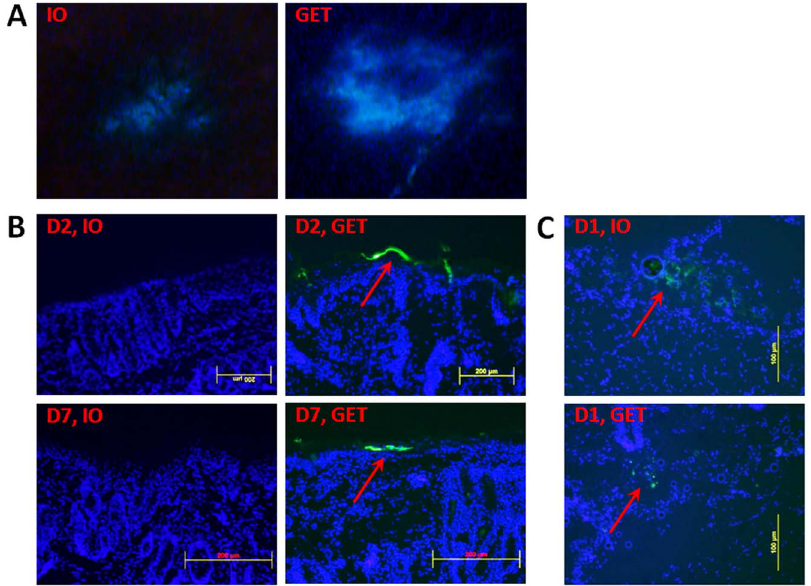
Figure 2. Distribution of GFP-expressing cells in HLGP skin after i.d. DNA injection and non-invasive GET. Skin samples were collected post-delivery day 1, day 2 or day 7. Samples were analyzed by fluorescent stereoscopy or microscopy. IO: DNA injection only without pulse delivery; GET: DNA injection with pulse delivery. A , One representative picture of 3 treated sites. (B, C) Total 6 cryosections (2 sections per sample) of each delivery were analyzed. Cell nuclei were blue-stained by DAPI. GFP-expressing cells were shown green and indicated by arrow. B , One representative section of each delivery was presented for post-delivery day 2 or day 7(magnification =100, scale bar=200 m m). C , One representative section from post-delivery day 1 (magnification =200, scale bar=100 m m).